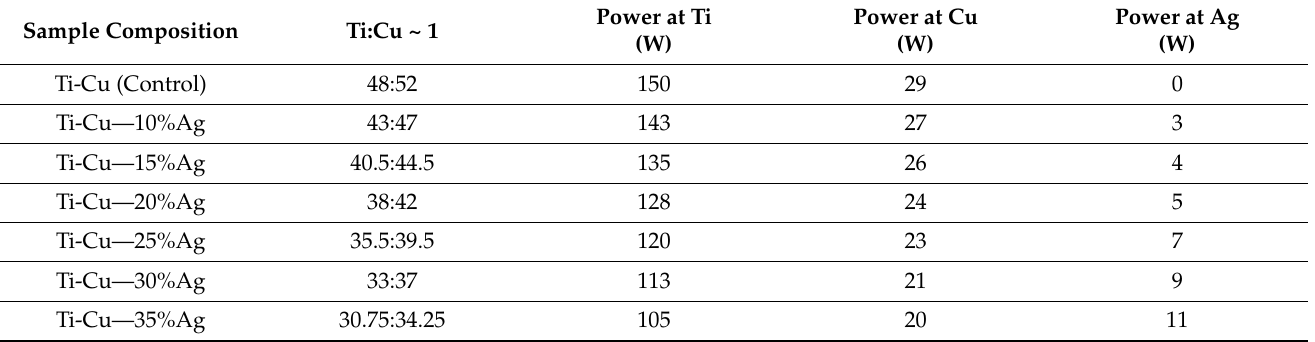
Figure 1. ( a ) Physical vapor deposition (PVD) chamber of three tilted metallic targets with respect to the substrate holder, and ( b ) targets ignite during sputtering. Table 1. Power supplied to metallic targets to obtain the desired